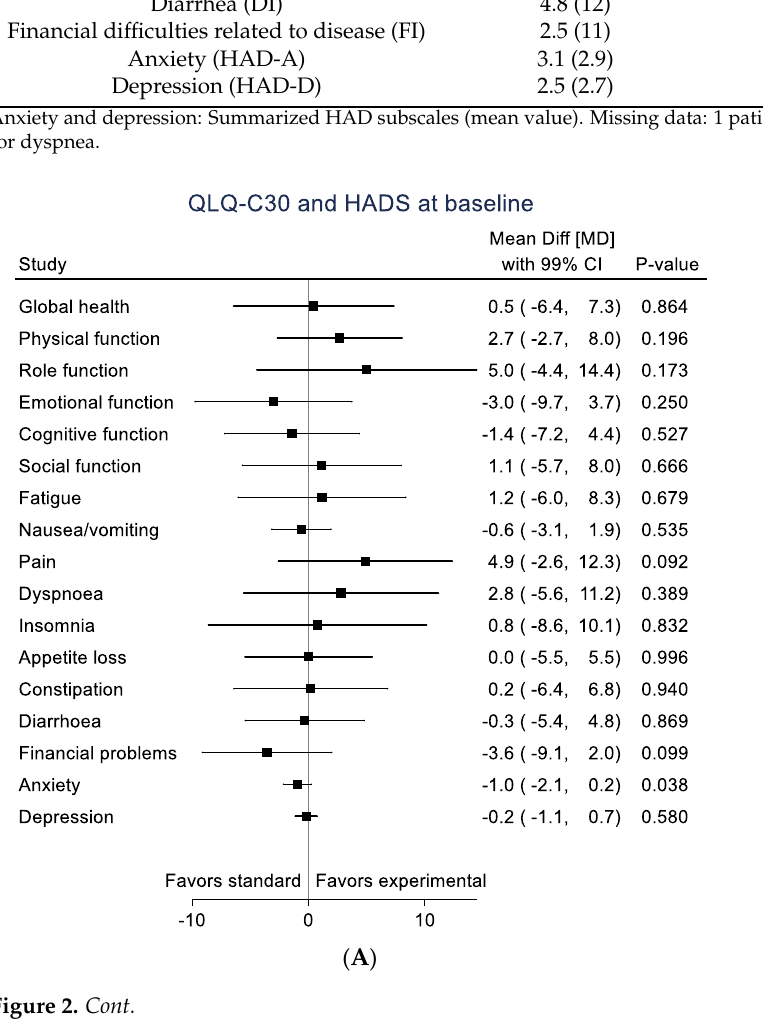
( B ) Figure 2. Black squares represent mean differences for each subscale with 99% CI. ( A ). QLQ − C30, HAD − A and HAD − D at baseline. ( B ). QLQ − C30, HAD − A and HAD − D at 1 year.